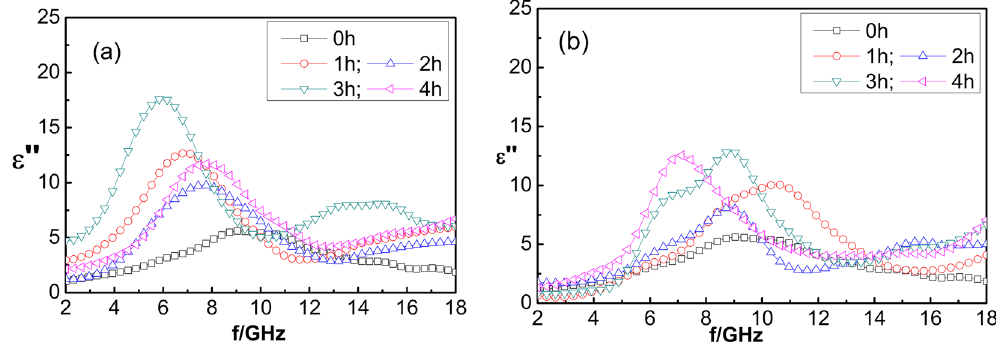
Figure 5. Imaginary part ( ε″ ) of the complex dielectric constant of CNT composites heat-treated for 1, 2, 3, and 4 h at temperatures of 700 °C and 900 °C; ε″ of the untreated composites is denoted as 0